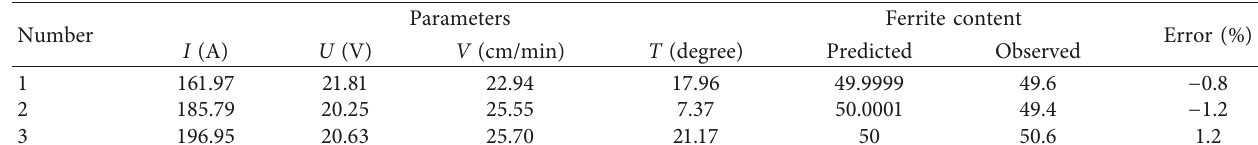
Table 7: Validation test results.